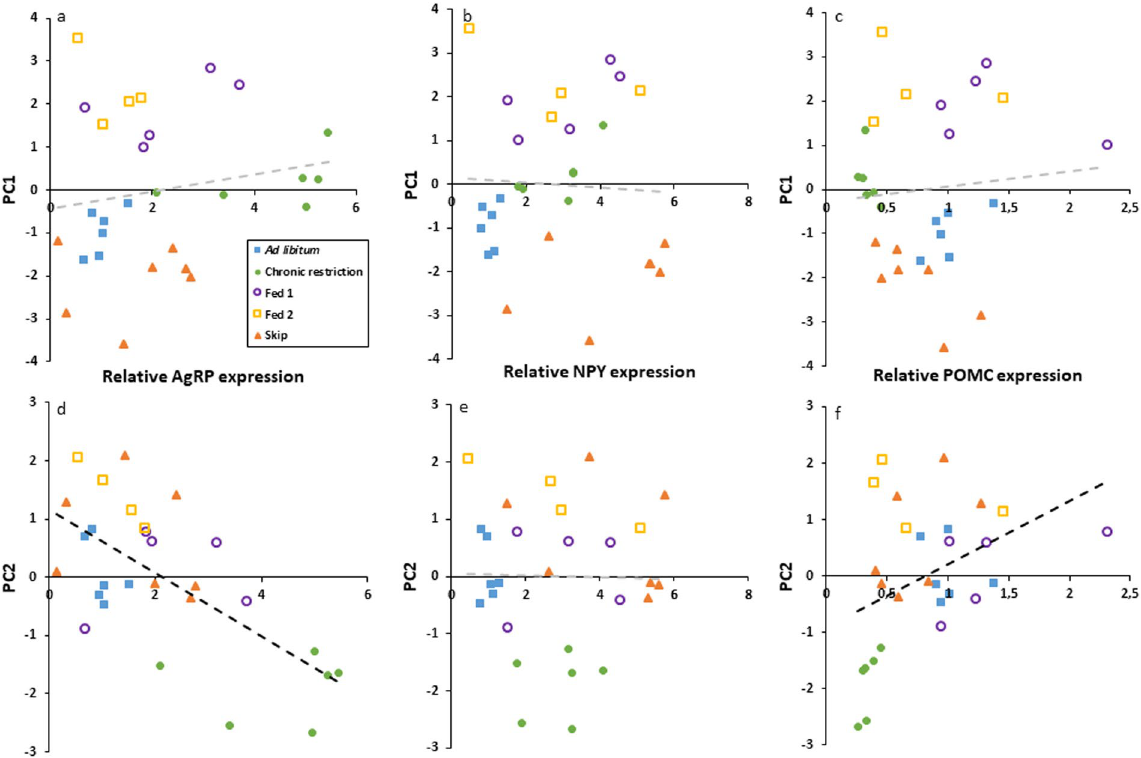
Figure 6. Individual regressions of the first two principal components (representing the variability in measured carcass traits) with basal hypothalamic gene expression of agouti-related peptide (AgRP, a/d), neuropeptide Y (NPY, b/e) and pro-opiomelanocortin (POMC, c/f) for Red Junglefowl chicks reared under ad libitum (blue, filled squares, N = 6), chronic feed restriction (green, filled circles, N = 6) and skip-a-day feeding, consisting of two feeding days, Fed 1 (purple, open circles, N = 5) and Fed 2 (yellow, open squares, N = 4), followed by a skip day (orange, filled triangles, N = 7). Significant associations between variables (regression analysis, p < 0.05) are marked in bold, non-significant associations are shown in